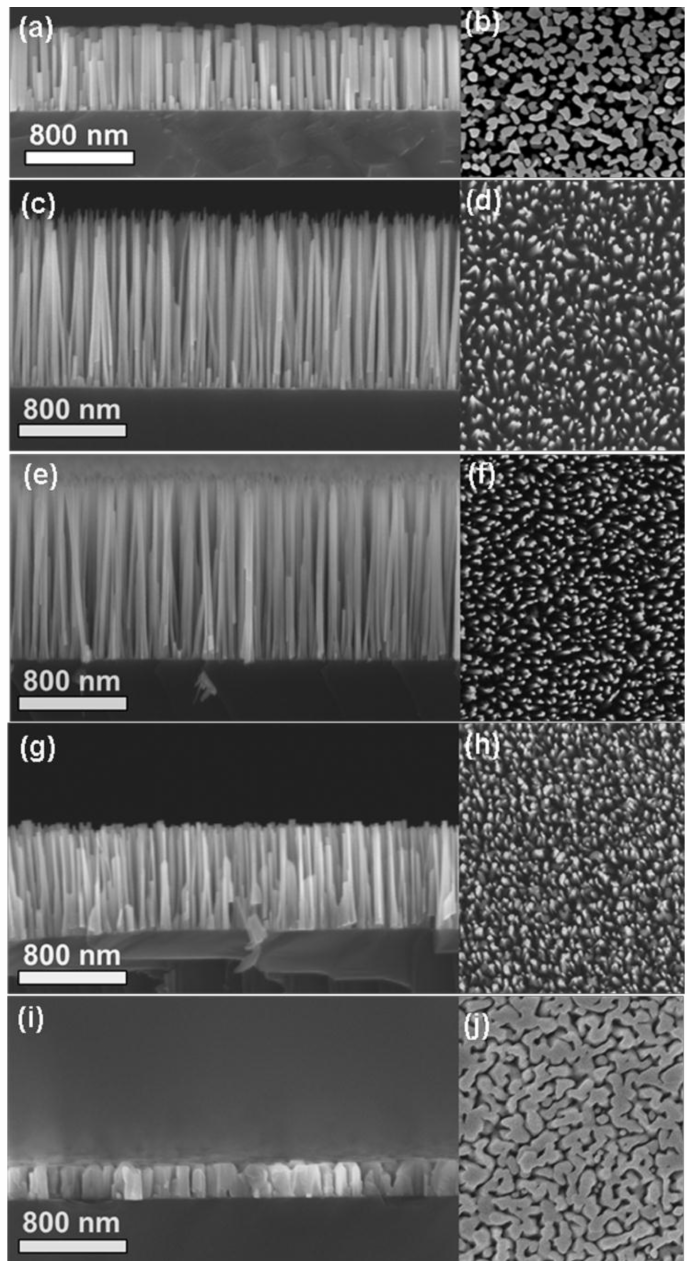
Figure 1. SEM micrographs showing side views ( left ) and top views ( right ) from GaN nanorod samples grown at ( a , b ) P N2 = 5 mTorr; ( c , d ) P N2 = 4.5 mTorr; ( e , f ) P N2 = 3.5 mTorr; ( g , h ) P N2 = 2.5 mTorr; ( i , j ) P N2 = 1 mTorr pressure on Si(111)